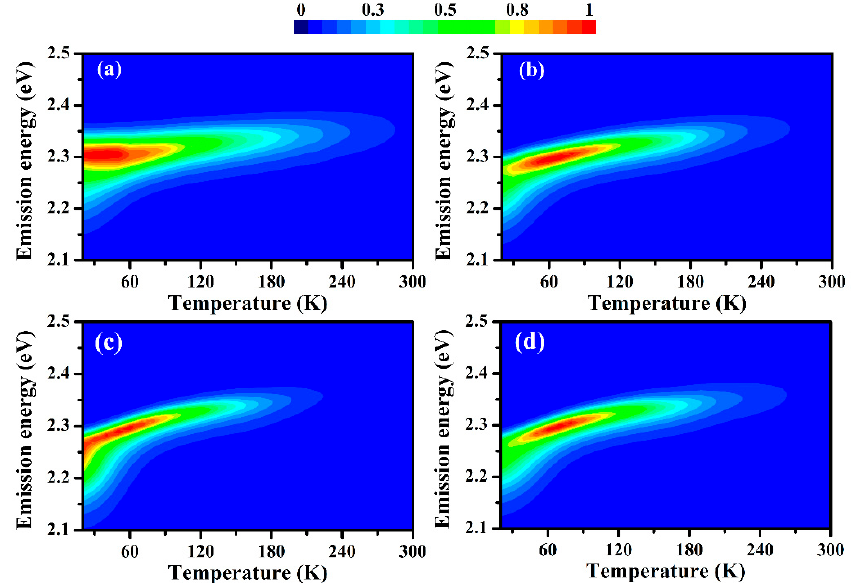
Figure 5. Pseudo-color maps of temperature-dependent PL spectra of MBNCs-PVDF: ( a ) Pristine; ( b ) after aging in N 2 ; ( c ) after aging in vacuum; and ( d ) after aging in an air atmosphere. The aging temperature and 368 nm UV light illumination density of ( b )–( d ) are 323 K and 5.6 mW/cm 2 .